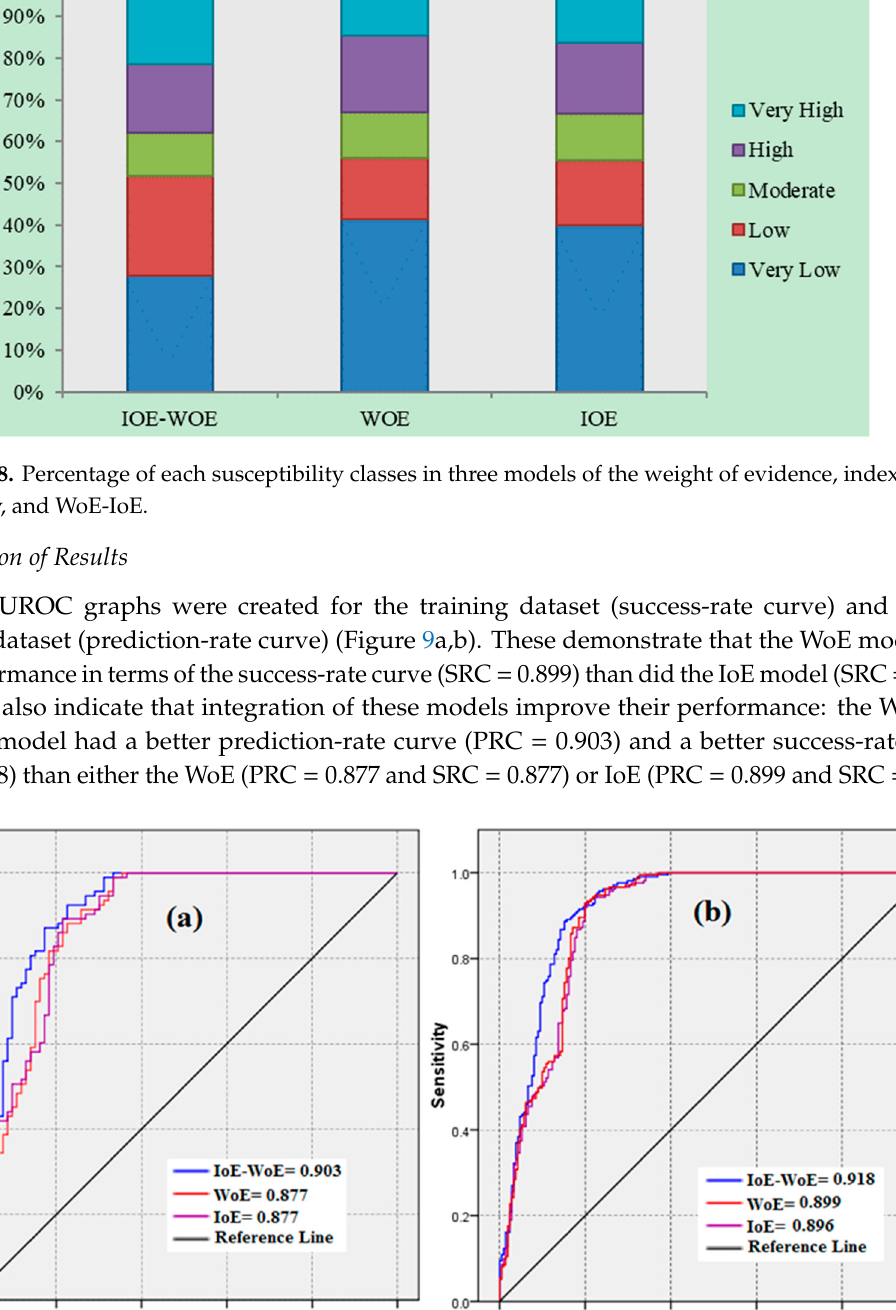
Figure 7. Gully erosion susceptibility map. ( a ) weight-of-evidence (WoE) model, ( b ) index-of-entropy (IoE) model, and ( c ) WoE-IoE integrated model.